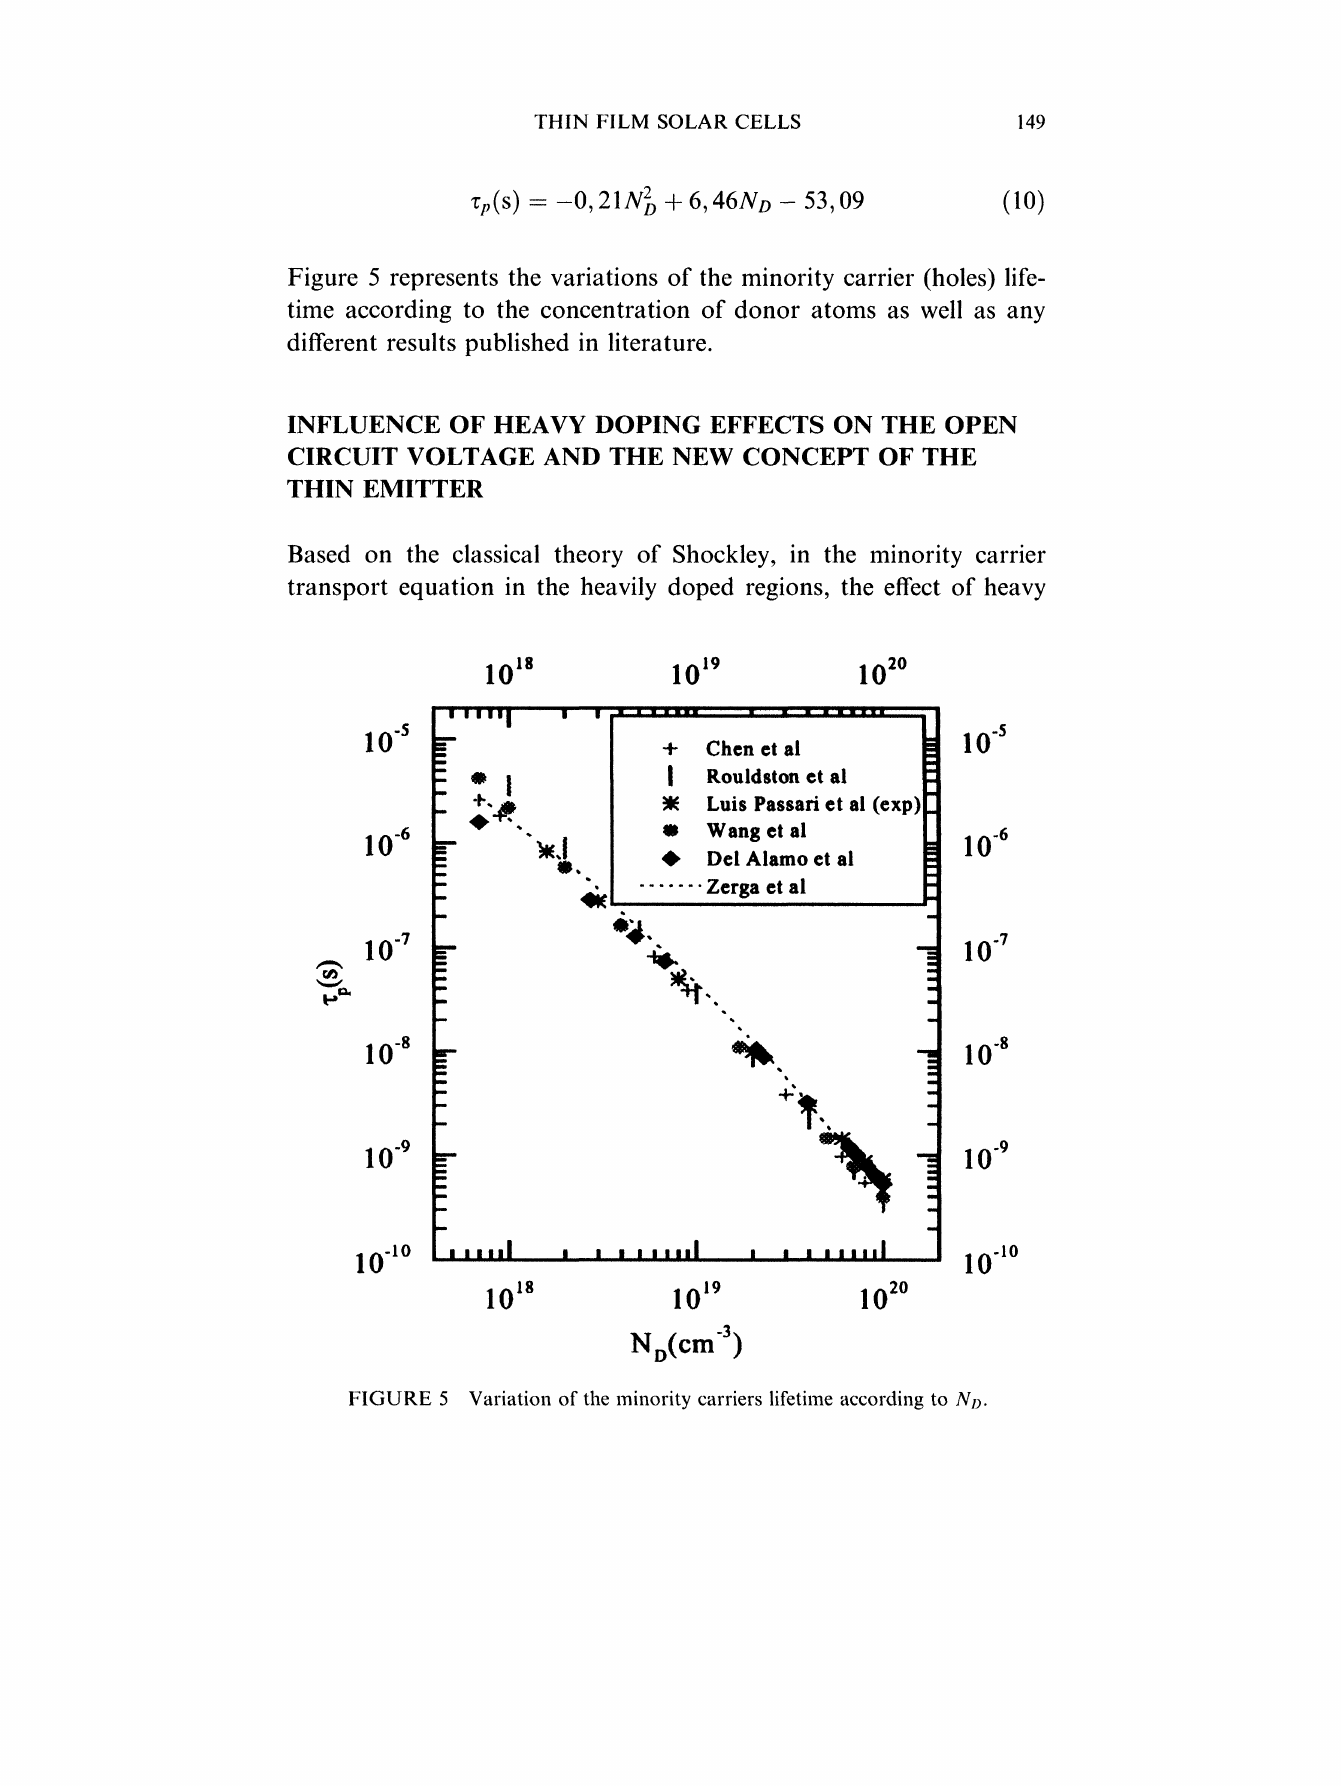
FIGURE 5 Variation of the minority carriers lifetime according to